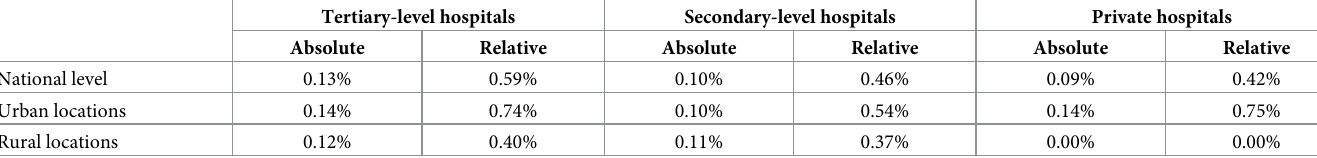
Table 3. Absolute and relative increases in poverty headcount ratios due to out-of-pocket